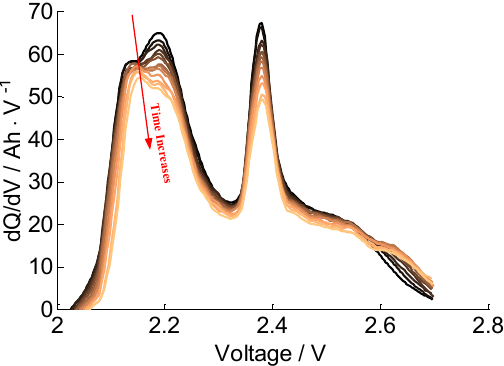
Figure 5. The IC curves of Cell A after every 90 cycles up to 1080 cycles; with cycle number increase, line color changes from black to